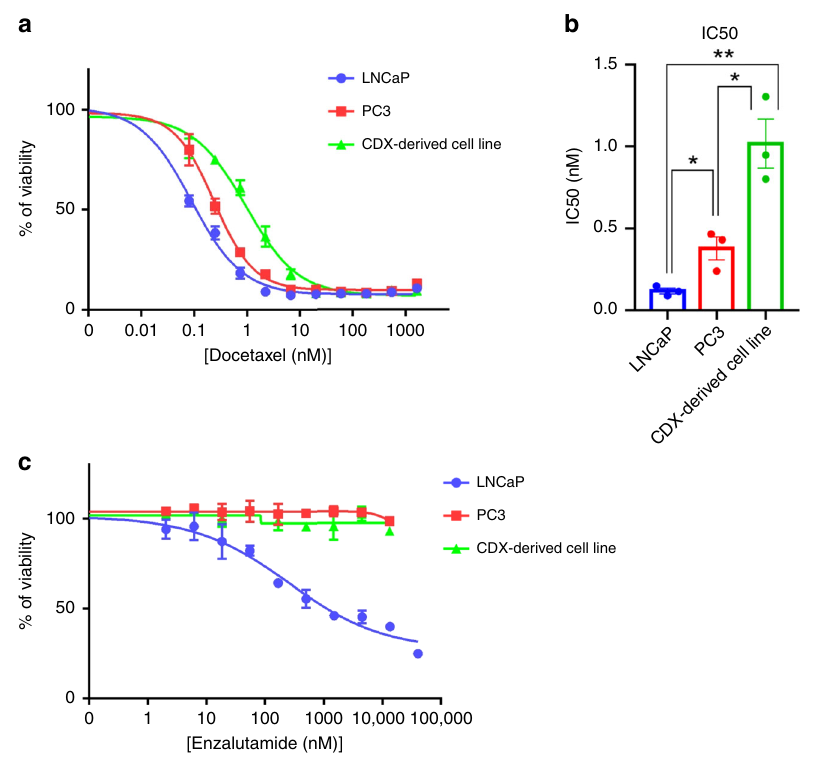
Fig. 9 In vitro drug assays. a Representative experiment of dose response curves of the CDX-derived cell line, LNCaP, and PC3 cell lines to docetaxel. IC 50 were 0.09, 0.24, and 0.95 nM for LNCaP, PC3, and the CDX-derived cell line respectively. b Mean of IC 50 values of docetaxel for the CDX-derived cell line, LNCaP, and PC3 cell lines. Data are presented as means ± SD of at least three independent experiments. An unpaired two-tailed t -test has been applied for statistical analysis. c Dose response curves of the CDX-derived cell line, LNCaP, and PC3 cell lines to enzalutamide. IC 50 was 254.5 nM for LNCaP and was not reached for PC3 and the CDX-derived cell